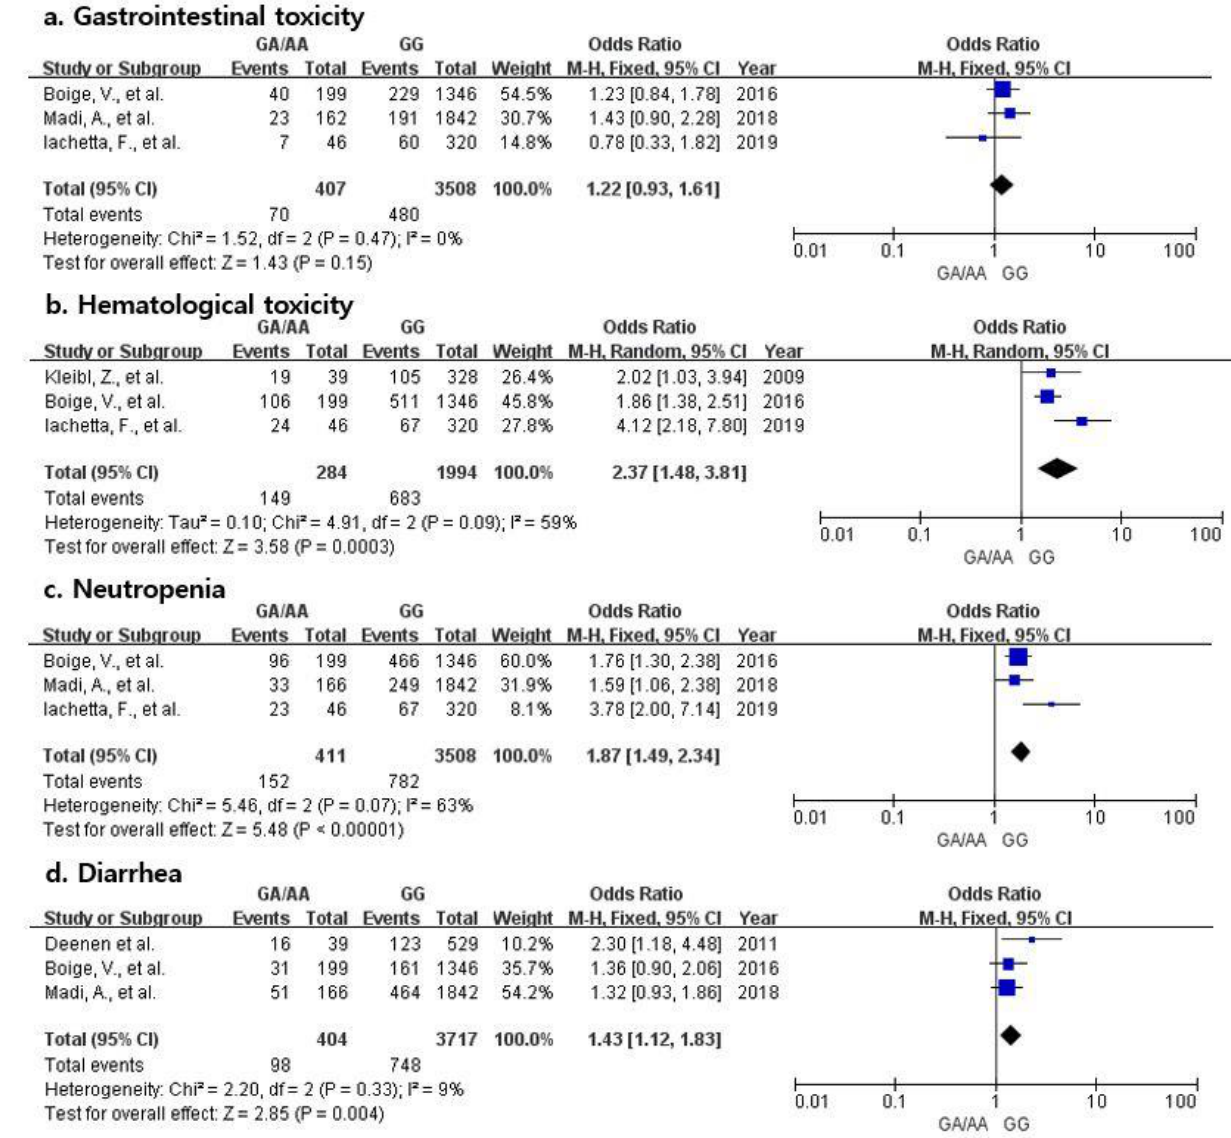
Figure 3. Forest plots of the association between fluoropyrimidine-induced toxicities and DPYD polymorphism: ( a ). gastrointestinal toxicity; ( b ). hematological toxicity; ( c ). neutropenia; ( d ). diarrhea.